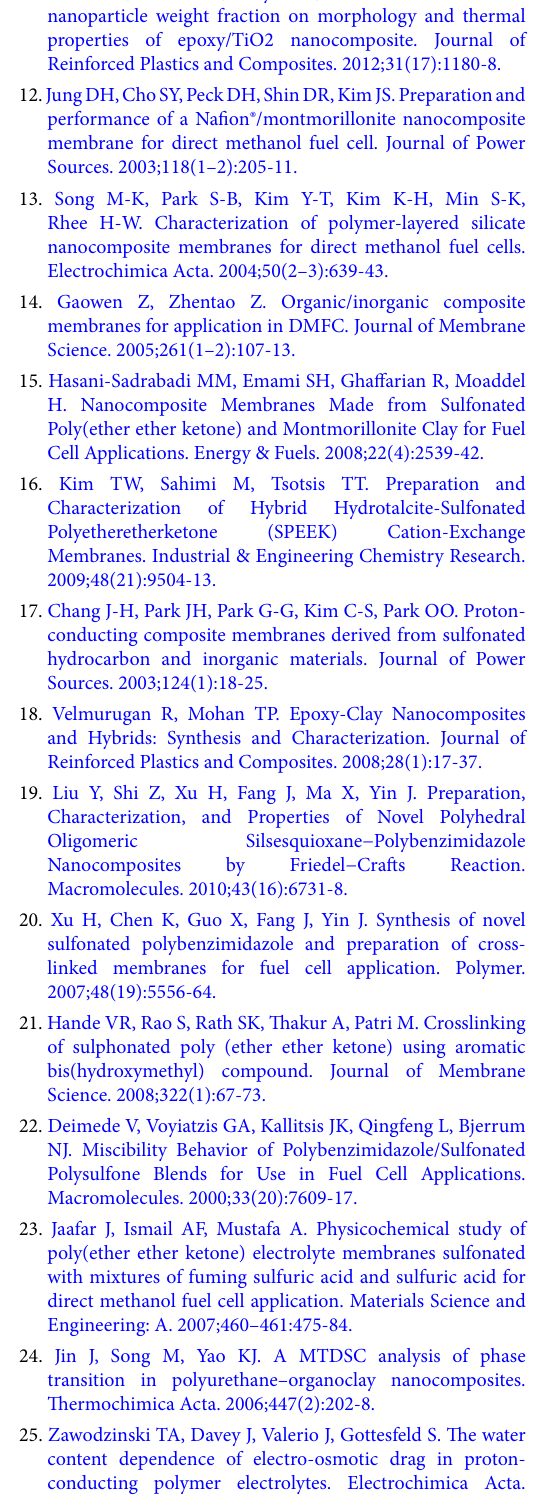
107 Nanochem Res 2(1): 96-108, Winter and Spring